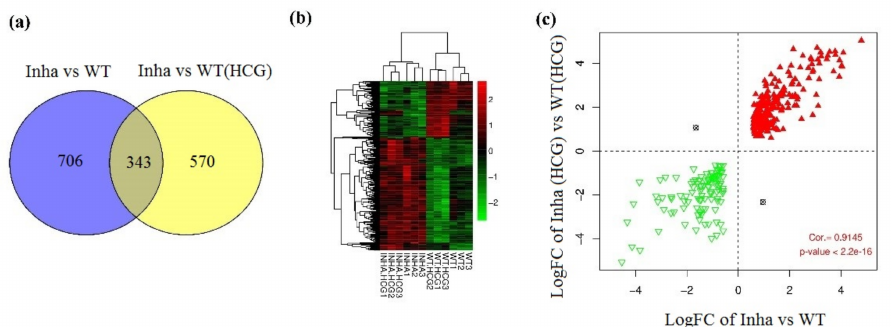
Figure 2. ( a ) Venn diagram of DEGs in groups Inha − / − vs. WT and Inha − / − (hCG) vs. WT(hCG). ( b ) Hierarchical clustering heatmap of overlapping DEGs. ( c ) Scatter-plot of correlation between logFC of Inha − / − vs. WT and Inha − / − (hCG) vs. WT(hCG). The red triangle and green inverted triangle refer to up and down-regulated DEGs in both Inha − / − vs. WT and Inha − / − (hCG) vs.